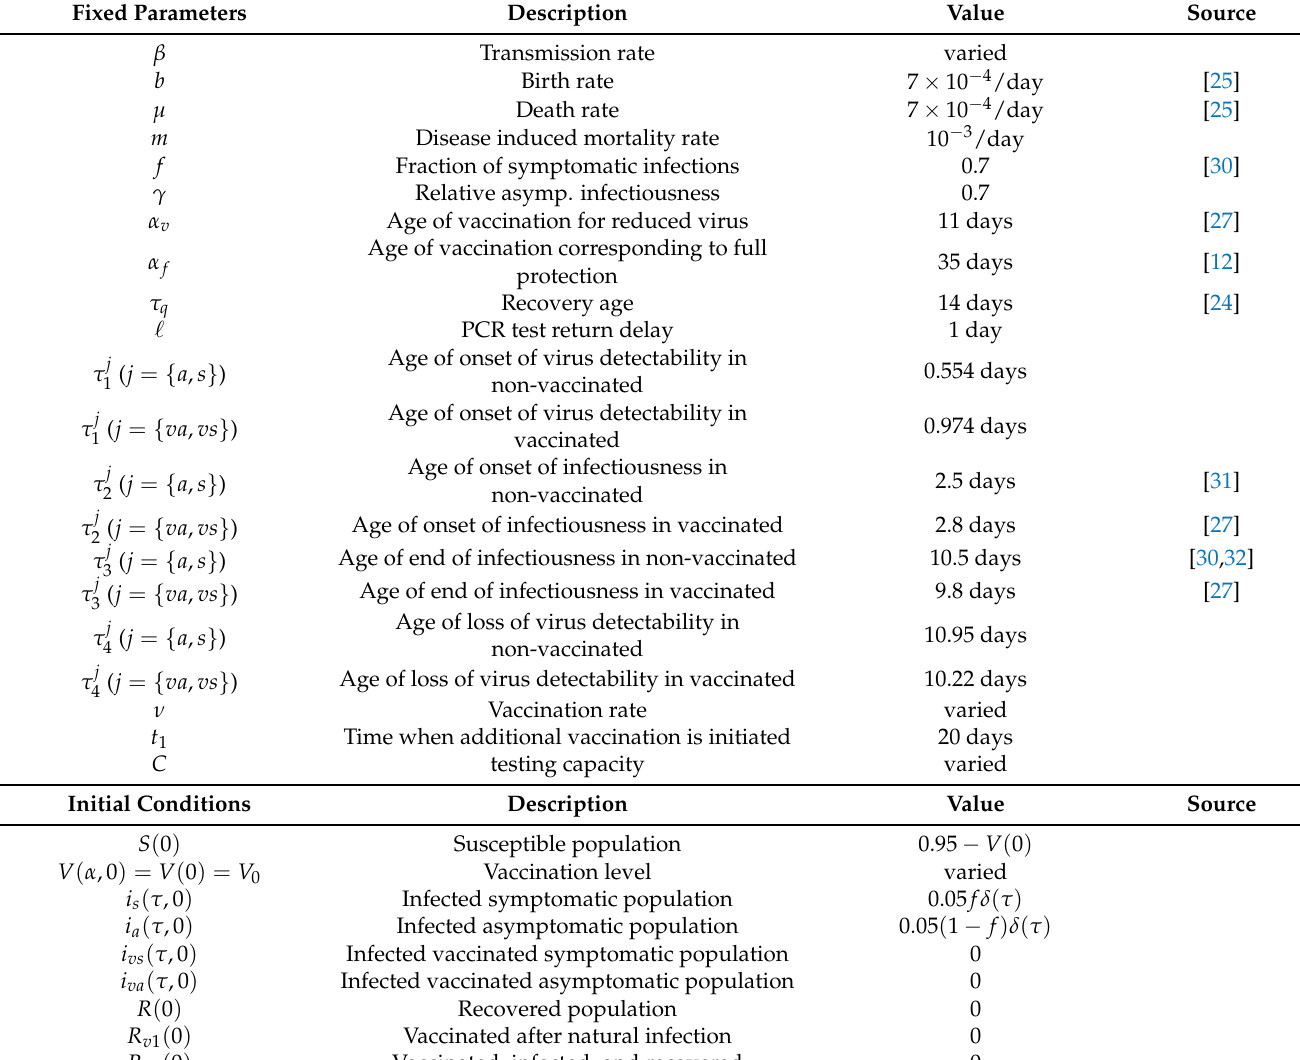
Table 1. Parameter values and initial conditions used in model Equation